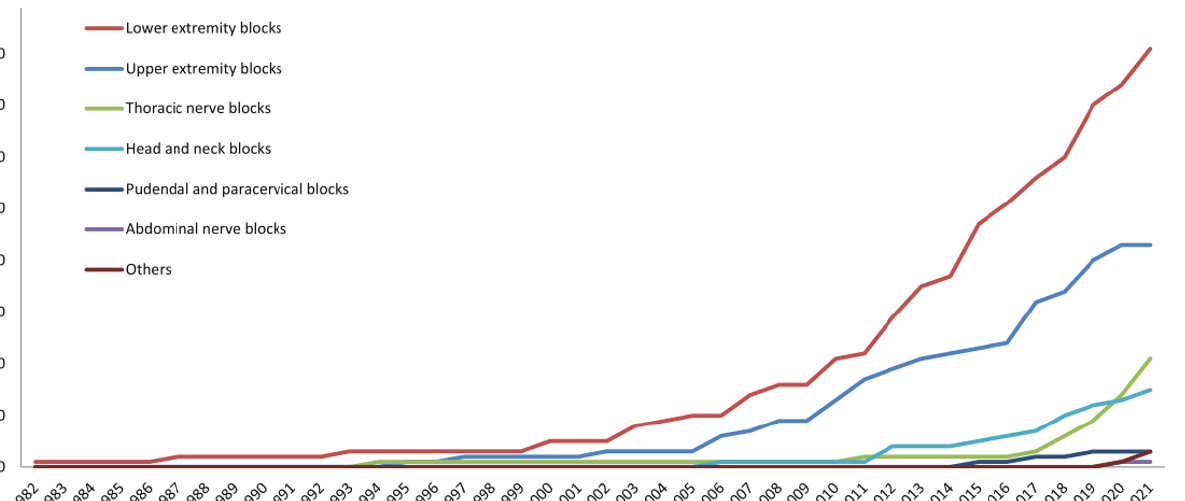
Figure 2. Timeline of published research on regional anesthesia since first being described in 1982. The graph shows an increasing trend in the use of lower extremity blocks, upper extremity blocks, thoracic nerve blocks, and head and neck blocks by emergency physicians.